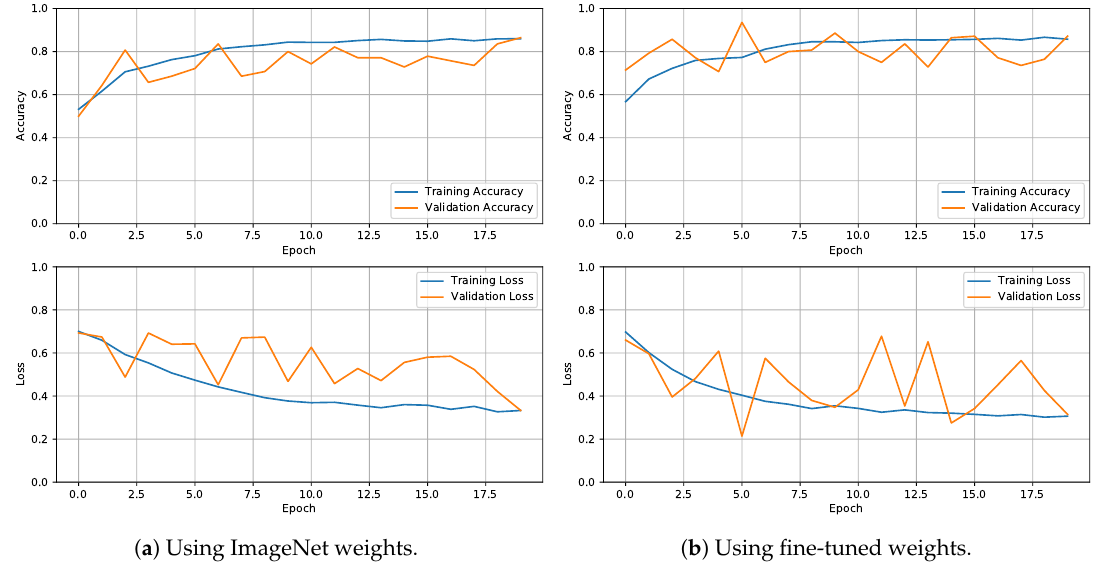
Figure 6. Training evolution graph of the Dynamic Collision Avoidance (DCA) model with the